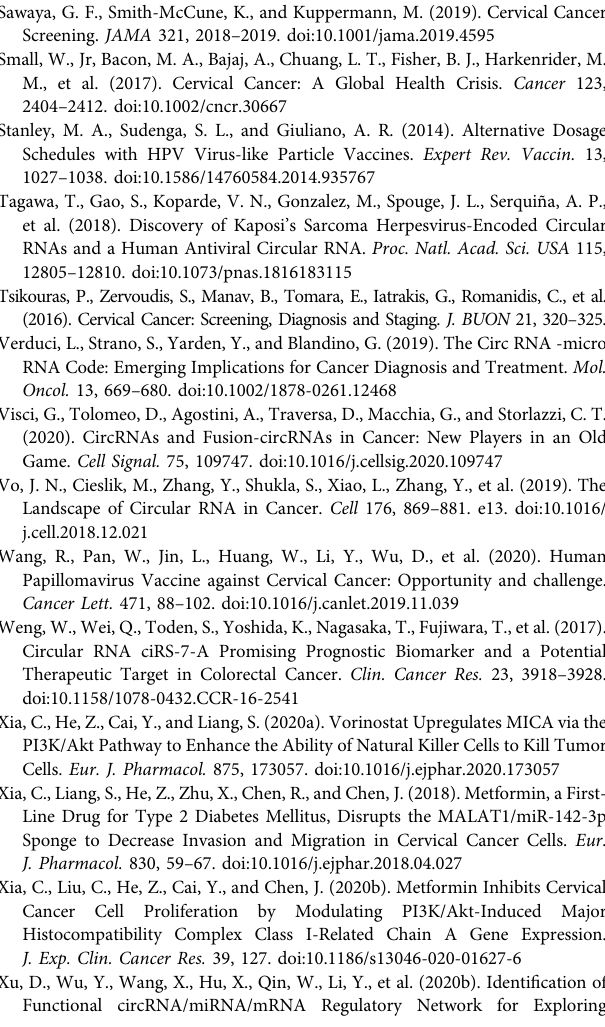
Supplementary Figure S1 | GO analysis was used to analyze (A) the biological process ofdifferential expression ofcircRNA, (B) thecell compositionofdifferentially expressed circRNA, and (C) the molecular function of differentially expressed